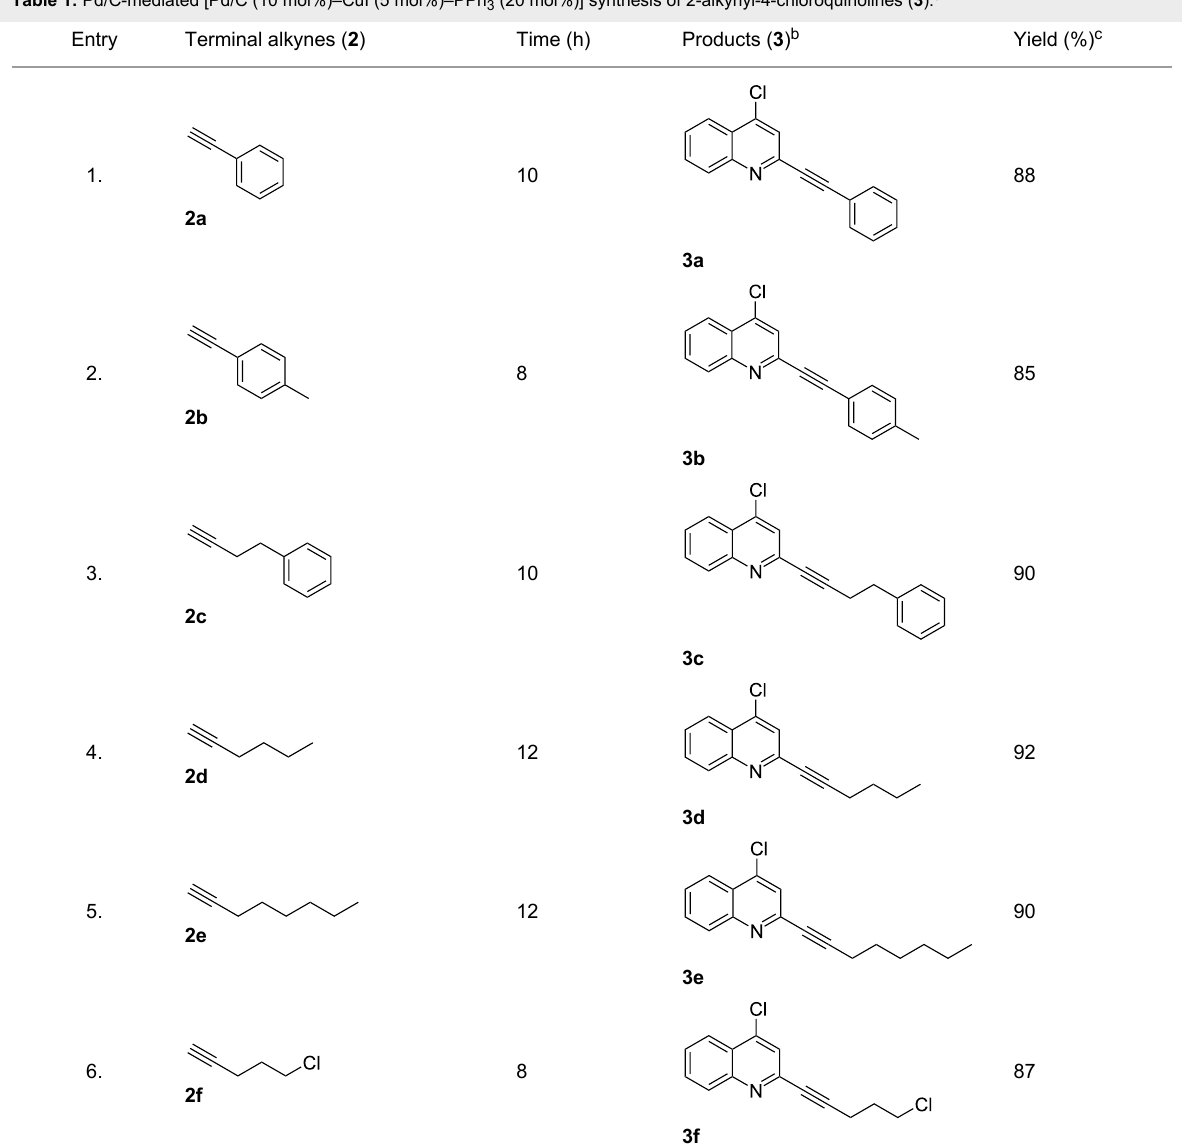
Table 1: Pd/C-mediated [Pd/C (10 mol%)–CuI (5 mol%)–PPh 3 (20 mol%)] synthesis of 2-alkynyl-4-chloroquinolines ( 3 ).